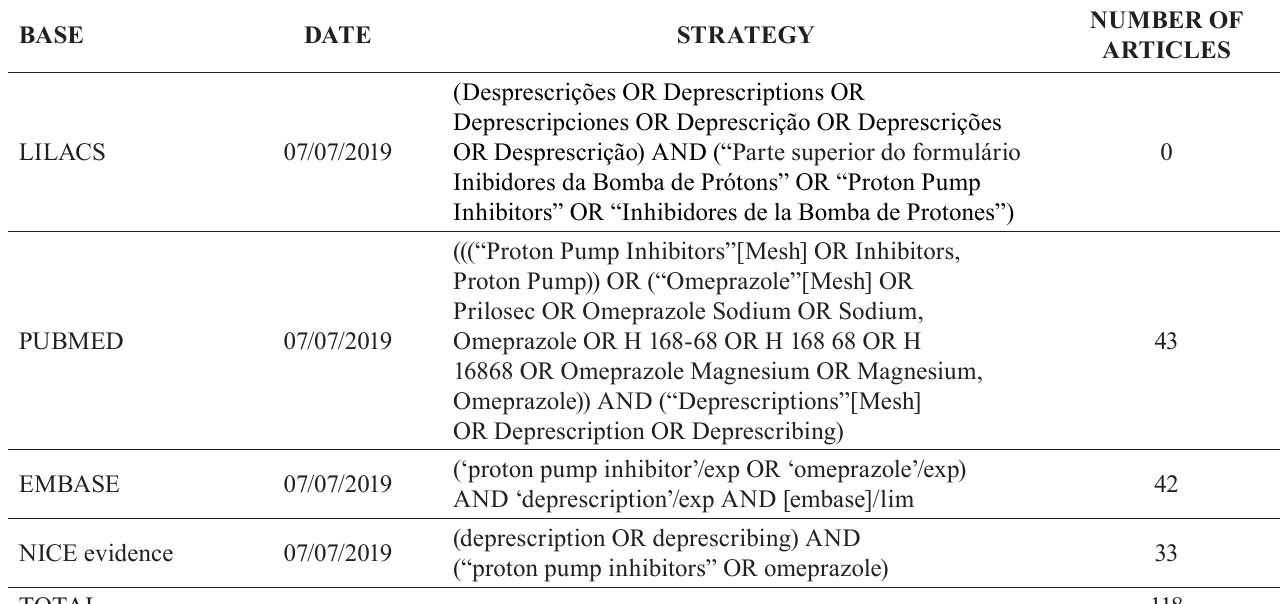
TABLE II - Characteristics of the included studies